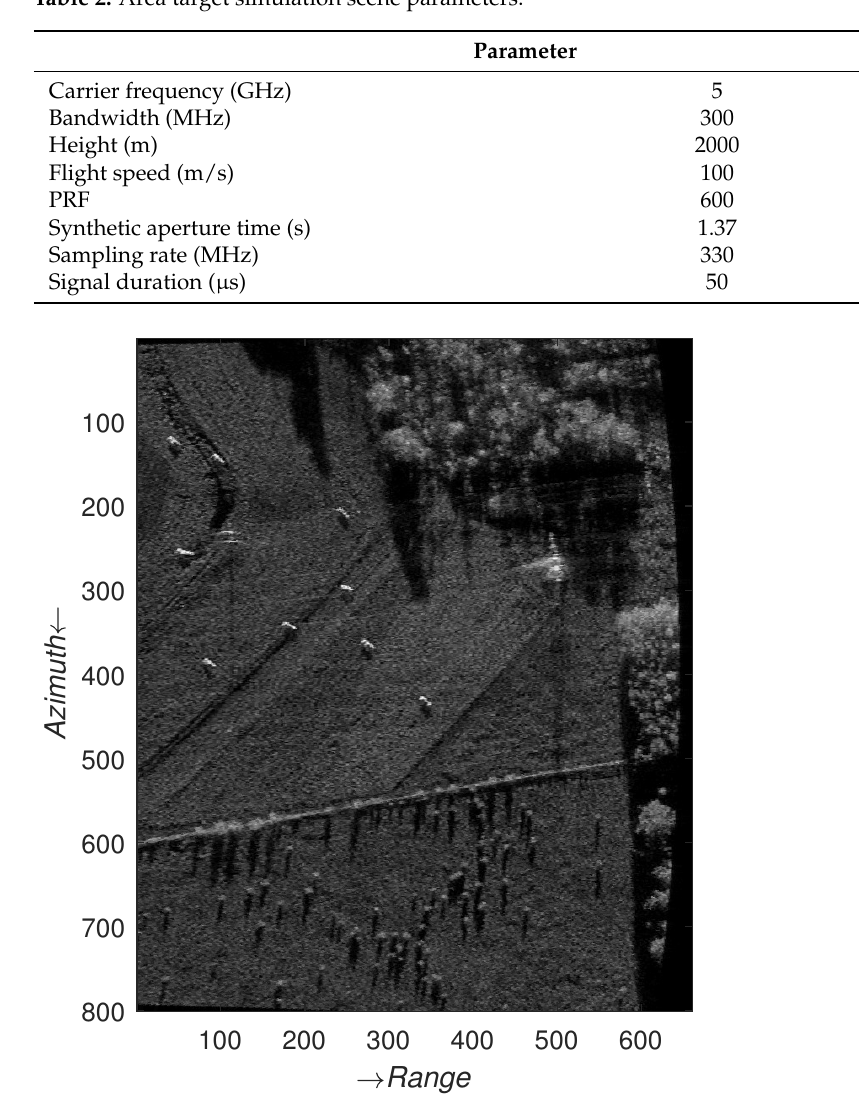
Figure 11. Imaging result of area targets.